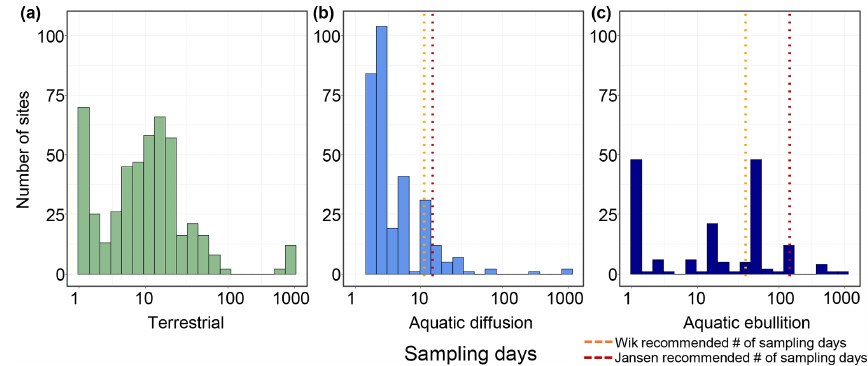
Figure 6. Histograms for the number of sampling days contributing to the average warm-season or ice-free season flux value. (a) Terrestrial flux sampling days. (b) Aquatic diffusion flux sampling days. (c) Aquatic ebullition sampling days. The dotted orange lines in (b) and (c) represent the number of recommended sampling days needed to arrive at a flux estimate within 20% accuracy (11d for diffusion and 39d for ebullition; Wik et al., 2016b). The dotted red lines represent an updated estimate of the number of sampling days needed including 14 and 135d for diffusion and ebullition, respectively (Jansen et al.,